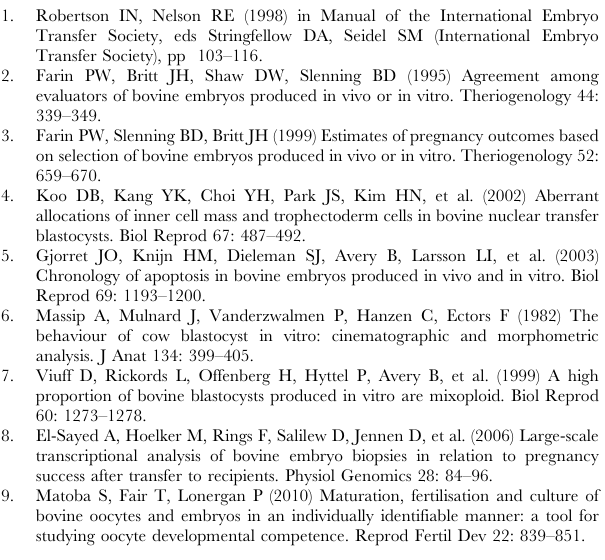
Figure S3 Correlation between oxygen consumption and mitotic index in blastocysts. The mitotic index is well recognized as an indicator of competence for cell growth. The correlation coefficient was determined with simple regression analysis. The coefficient of determination, r , was statistically significant at P , 0.01. Figure S4 Effect of oxygen consumption at blastocyst stage on pregnancy success. The boxes indicate the 25th and 75th percentiles, and the middle horizontal line indicates the median. Whiskers indicate the maximum and minimum values within the acceptable range defined by the two quartiles. Circles denote outliers. Data were analyzed with the Student t -test. Different letters are significantly difference at a,b P , 0.05. blastomeres (B).